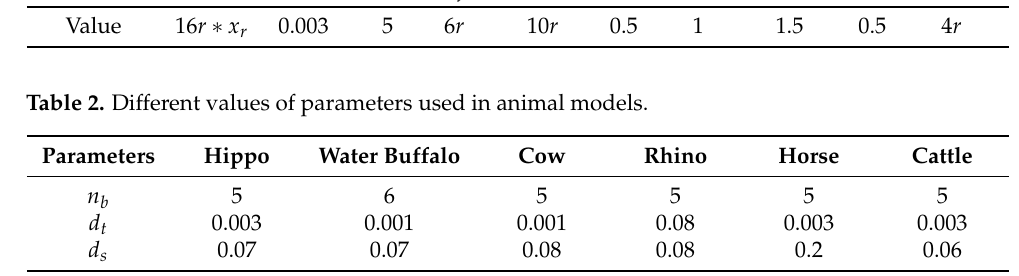
Table 1. The parameters discussed in Section 2.3. r is the resolution of the input point cloud. x r is the range of the x-coordinate value of the livestock data. d s is the maximum segment of the concave hull. d t and n b denote the stopping threshold and the number of branches of DSE, respectively. d f is the leaf size of the octree. d l is the distance threshold of the RANSAC algorithm for extracting the leg branch. d sr is the seed resolution of the supervoxel algorithm. a, b, and c are weight values of distance d ( p i , C j ) . d ∗ is the distance of the leg branches moving inward. Parameter